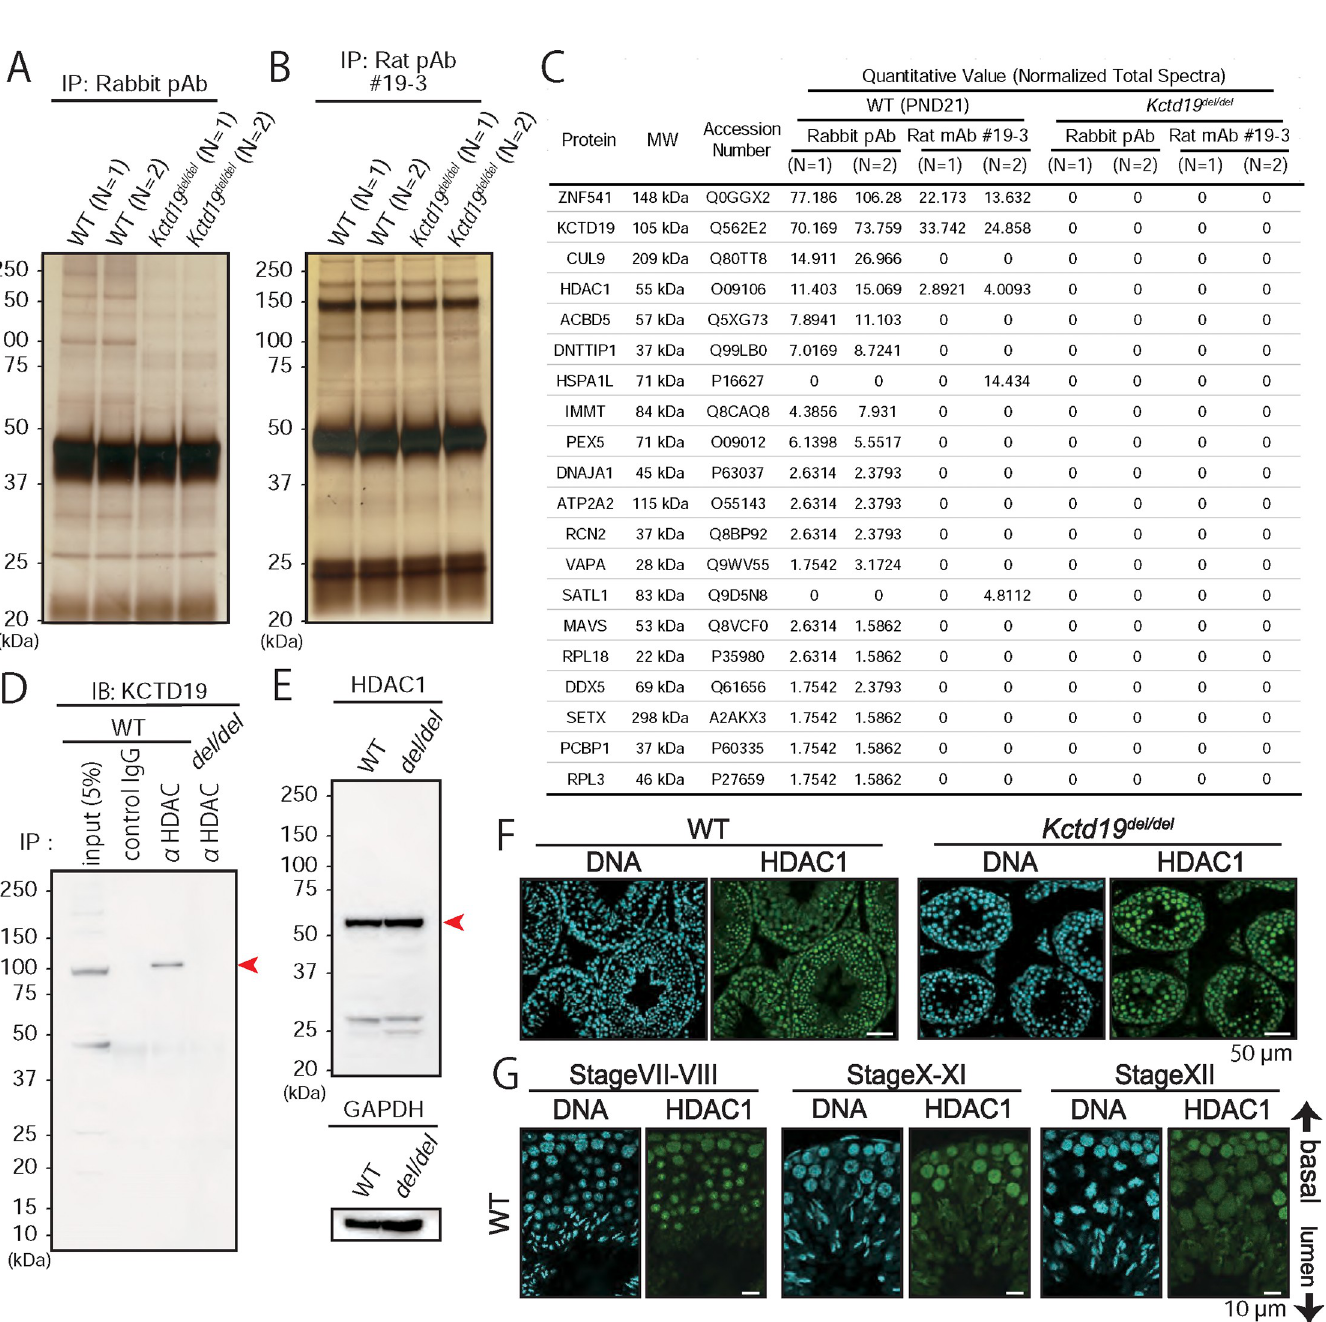
Fig 5. IP-MS analysis with anti-KCTD19 antibody. (A & B) Silver stain of eluted IP samples from rabbit pAb (A) and rat mAb #1 (B). Two juvenile WT mice and two adult Kctd19 del/del mice were used for each experiment. (C) The list of identified proteins by MS analysis. The quantitative value was calculated using Scaffold software. (D) Immunoprecipitation with an anti-HDAC1 antibody. For input sample, 50 μ g of testis lysate was used. (E) Immunoblotting with an anti-HDAC1 antibody. An anti- GPADH antibody was used as a loading control. (F and G) Immunostaining with an anti-HDAC1 antibody. The seminiferous epithelium cycle was determined by cell position, nuclear morphology, and morphology of the acrosome stained with Alexa Flour 568-conjugated lectin PNA.